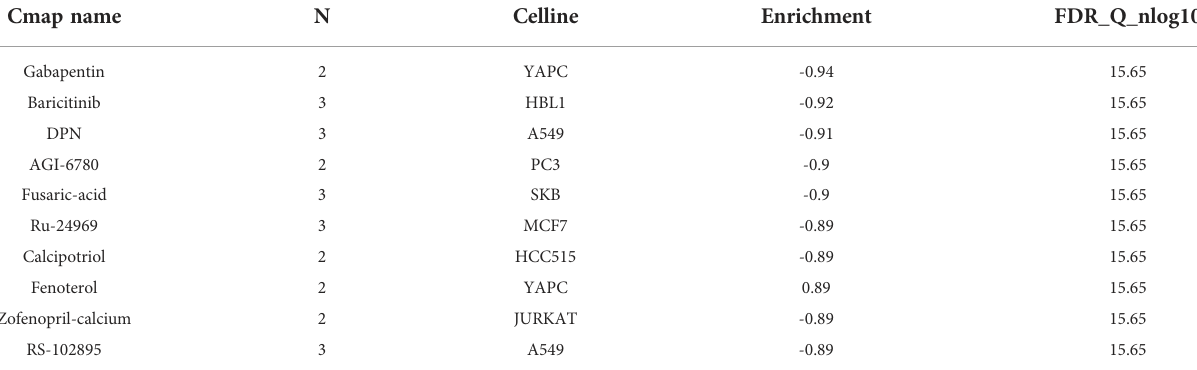
TABLE 1 Results of Cmap